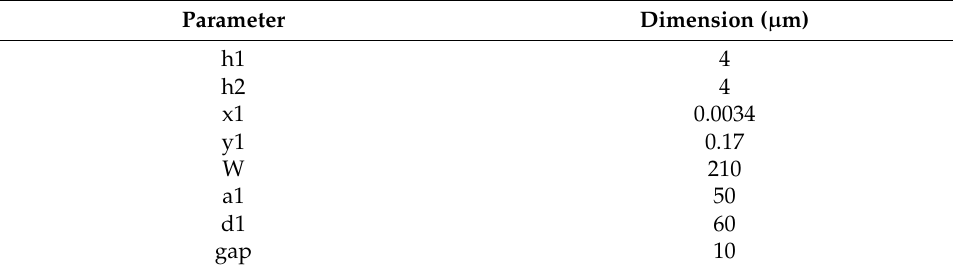
Figure 3. Group delay.